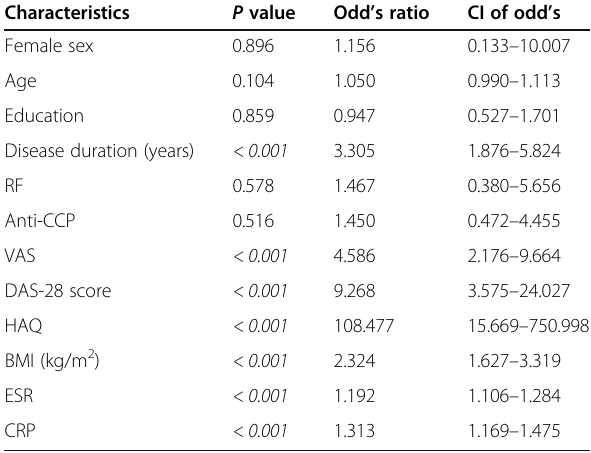
Table 3 Univariate binary logistic regression analysis of the possible risk factors for neuropathic pain among RA patients Characteristics